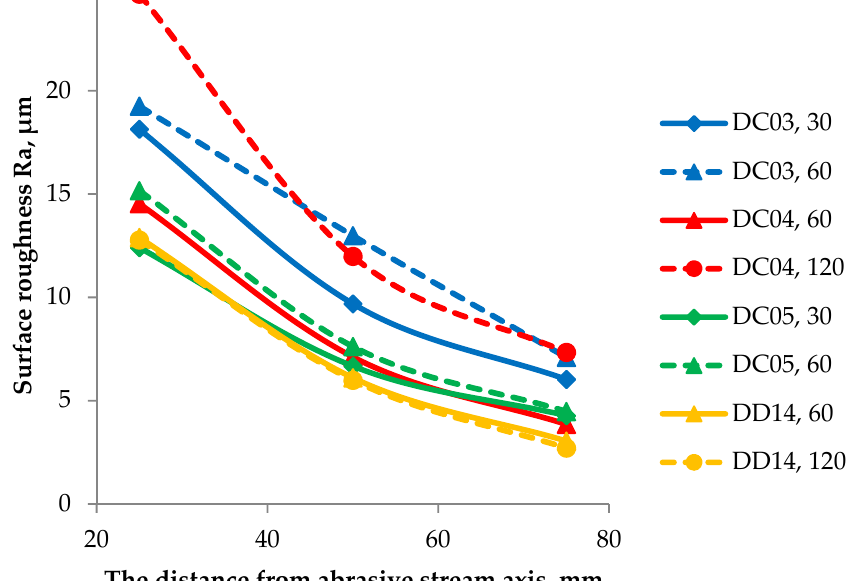
Figure 12. Surface roughness R a in relation to the distance of the sample from the crater axis for erosion test times of: (a) 30 s; (b) 60 s; (c) 120 s.